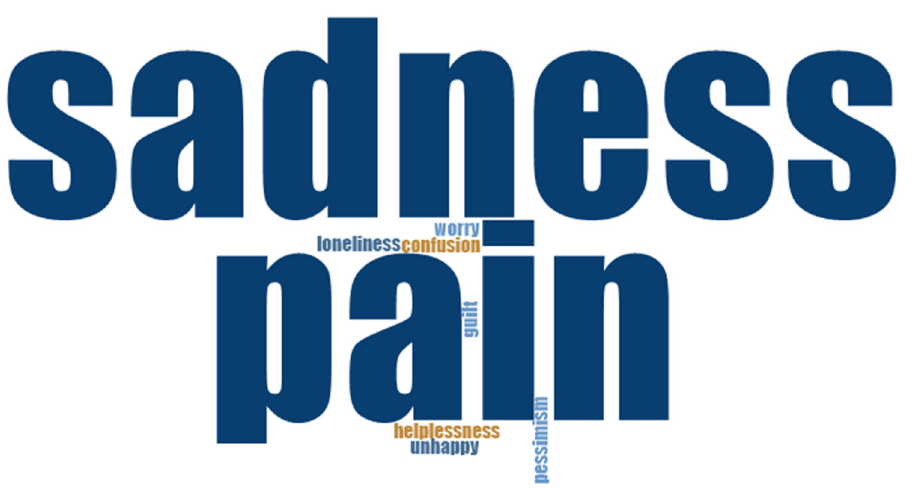
Figure 4. Negative emotions related to unhappiness: word cloud.